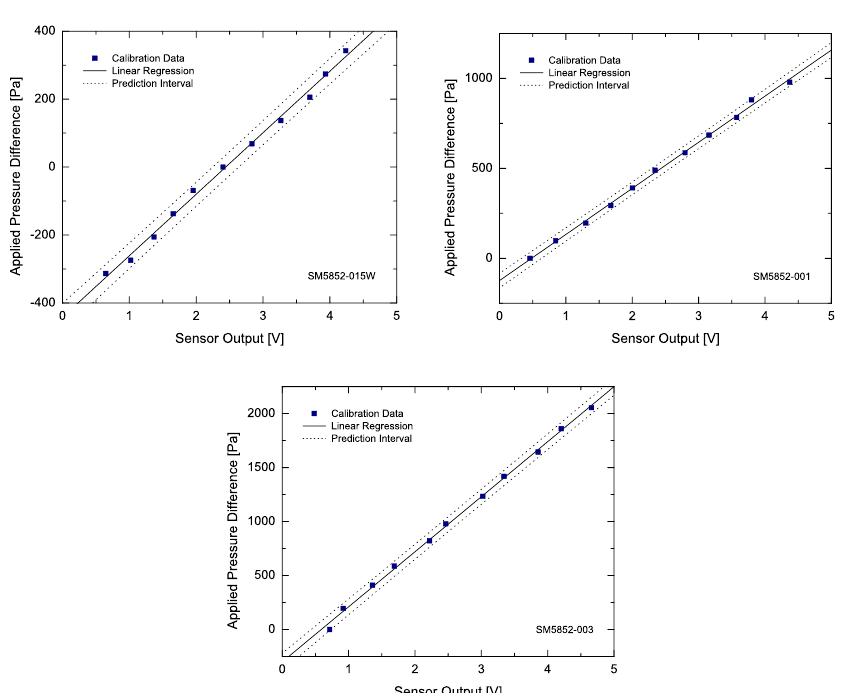
Figure A1. Calibration curves of the differential pressure sensors (a detailed description of the process can be found in Section 2.3). The prediction interval is for a confidence level of